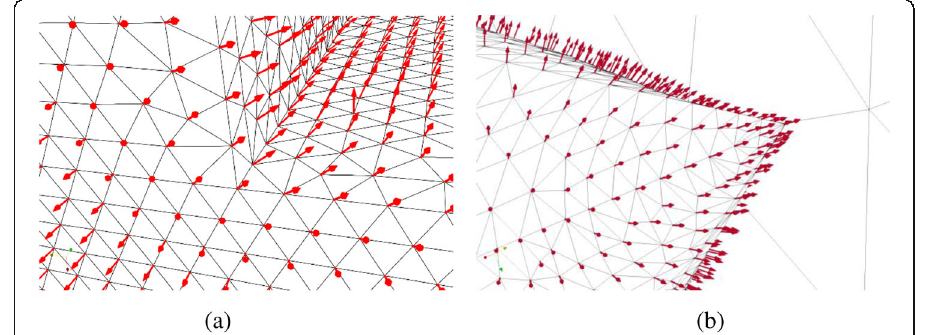
Fig. 3 Marching directions in the neighbourhood of two different types of corners. ( a ) A concave corner.